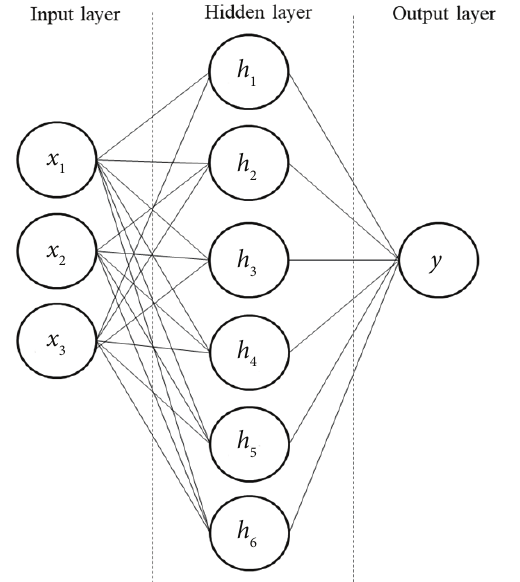
Figure 1. Example of a neural network